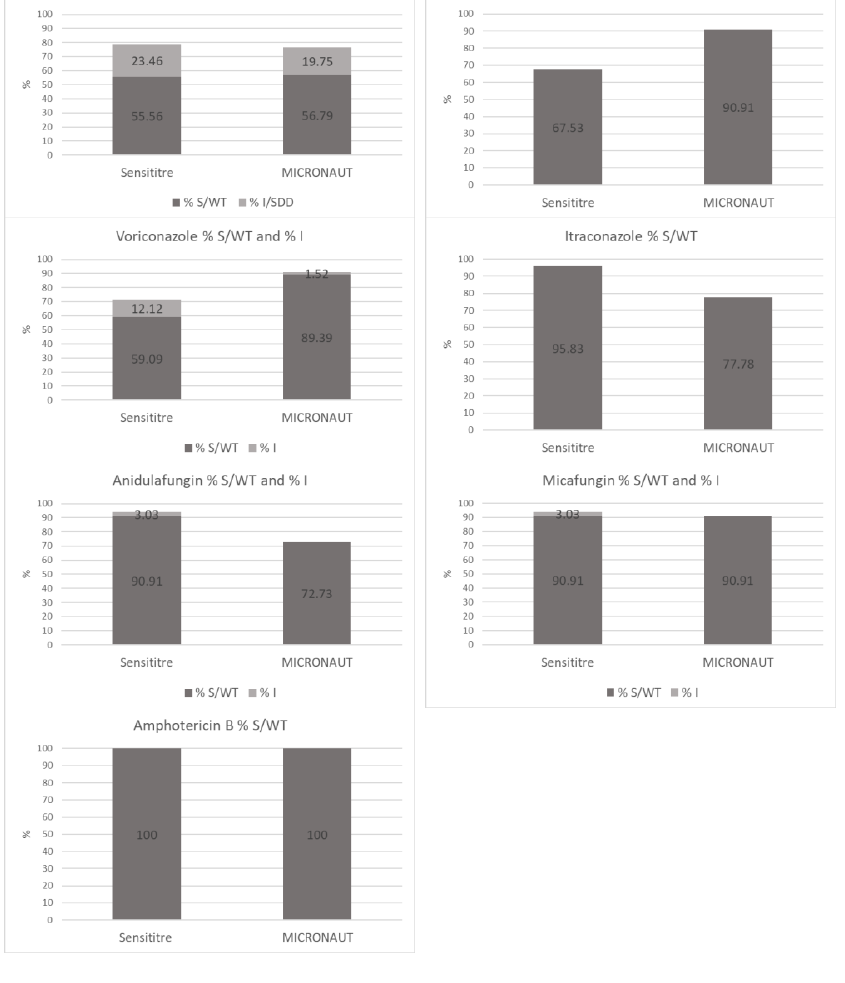
Figure 2. Comparison of SY versus M-AM: percentage of S/WT and I/SDD Candida isolates for each antifungal agent.